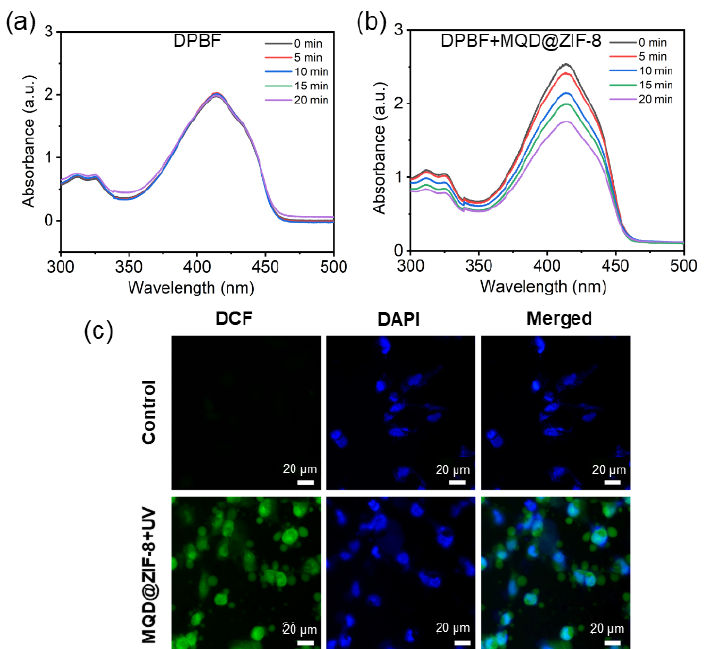
Figure 5. UV − Vis absorbance spectra of ( a ) DPBF and ( b ) DPBF with MQD@ZIF-8 under UV light irradiation; ( c ) confocal fluorescence images of 1 O 2 generation in HeLa cells.